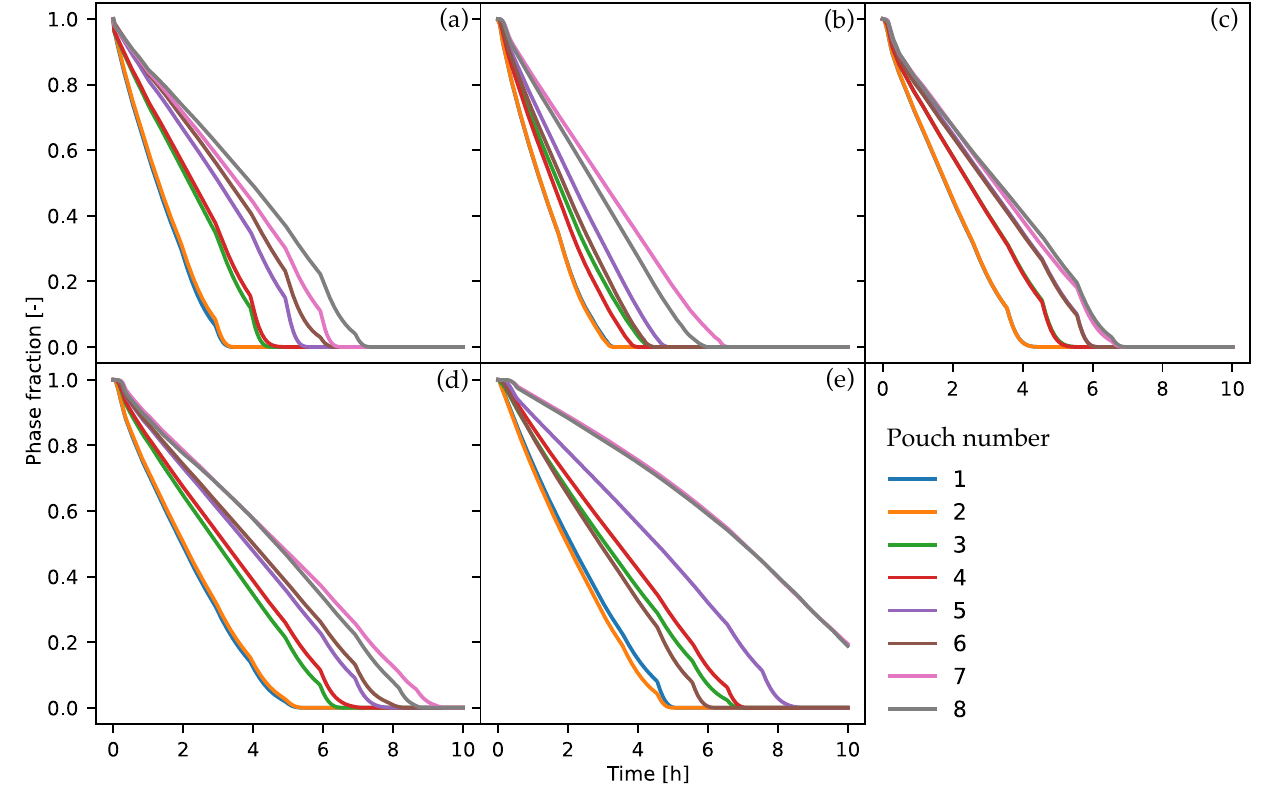
Figure 8. Evolution of solid phase fractions with time during the charging of PCM pouches for ( a ) PY, ( b ) PYO, ( c ) PYR, ( d ) CY, and ( e ) CYO designs. The phase change process ends when the phase fraction reaches zero. Delays in phase transitions were observed for each subsequent row of PCM pouches in all the investigated